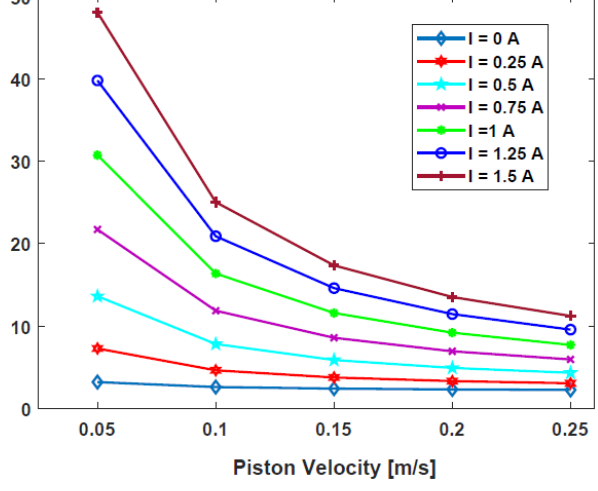
Figure 8. Dynamic ranges of the HARMRD under various excitation